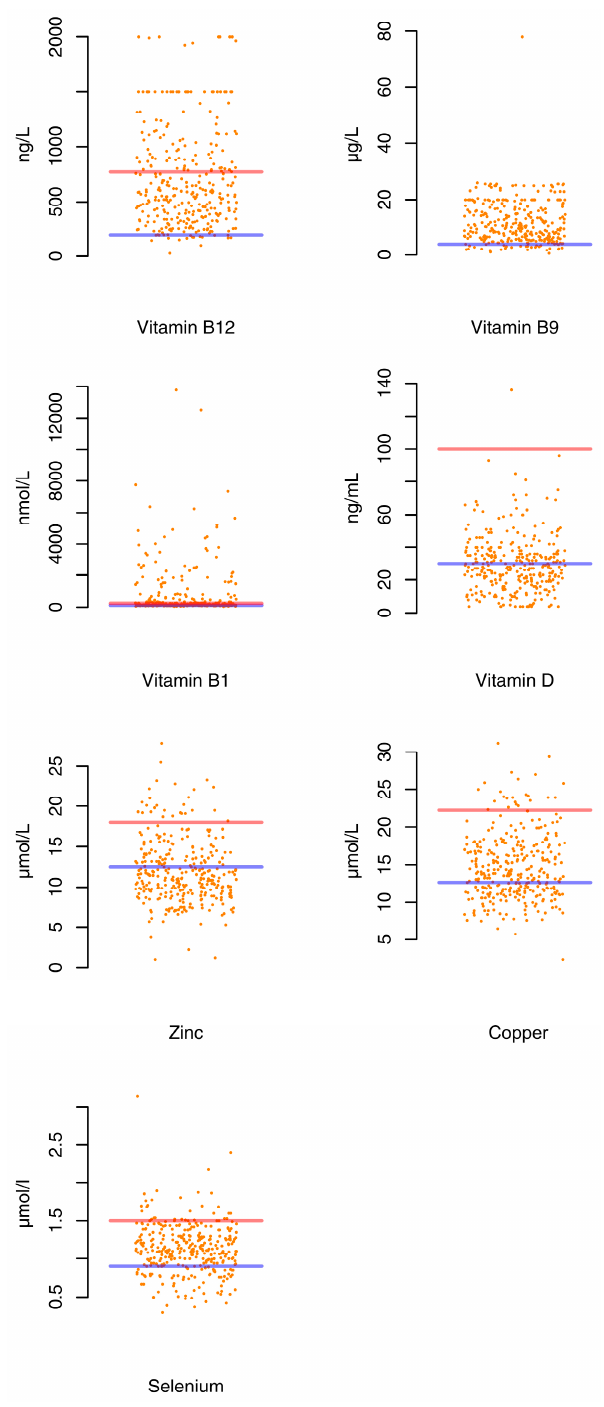
Figure 1. Micronutrients status in AN patients. Lower limits of normal micronutrients concentrations values are represented by blue lines and upper limits of normal values with redlines. Dots under the blue lines represent micronutrient deficiencies in AN